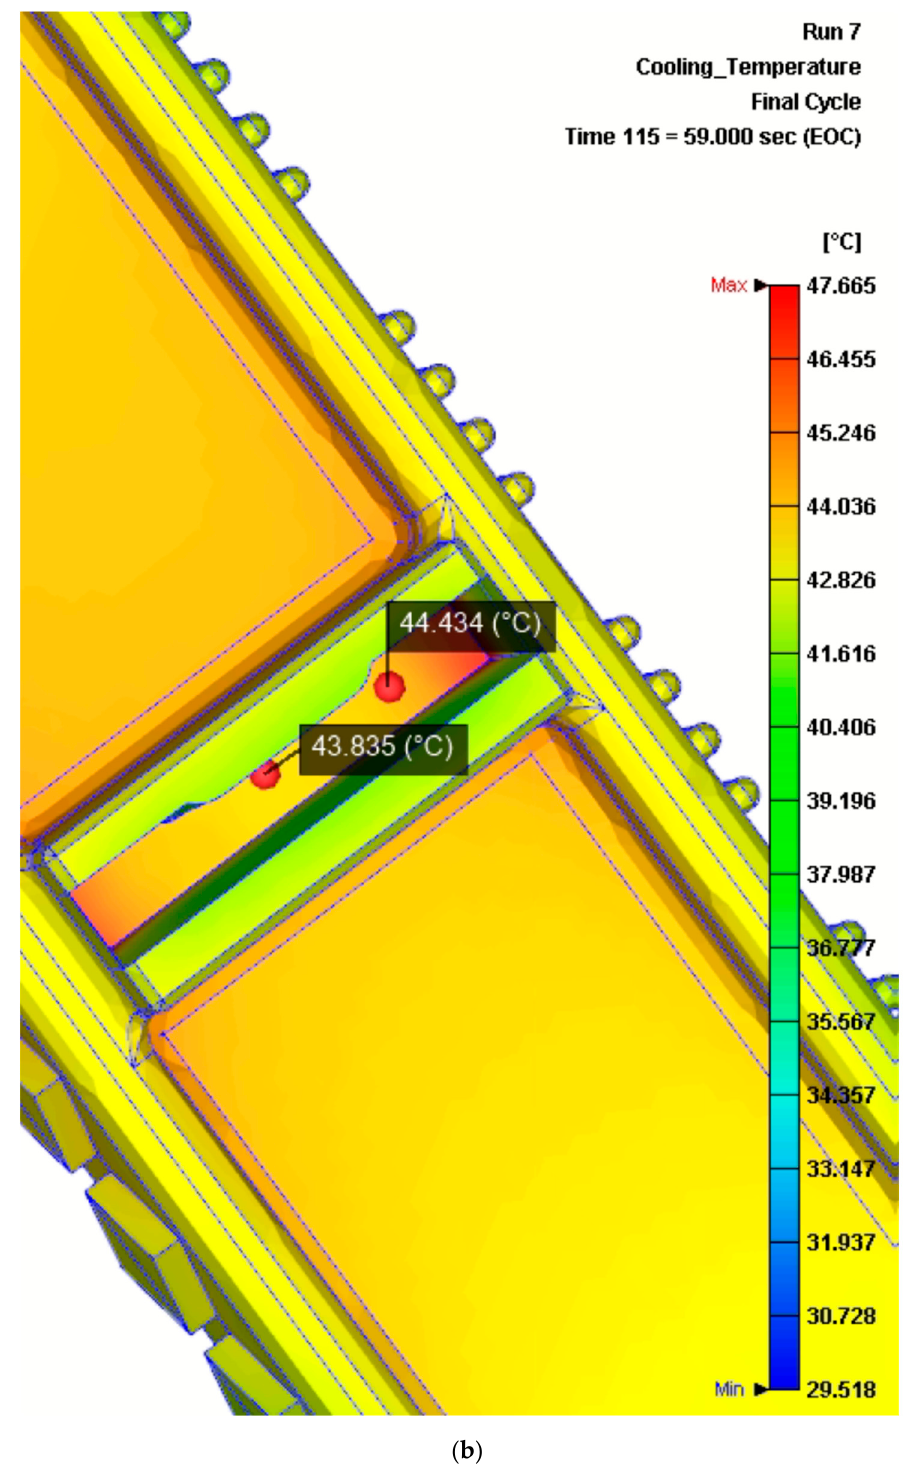
Figure 7. Results of the rib temperature distribution numerical analysis obtained at time = 59 s with Moldex3d. ( a ) Temperature distribution of a rib using the original insert (without conformal cooling). ( b ) Temperature distribution of a rib using the redesign of the insert (with conformal cooling channels).